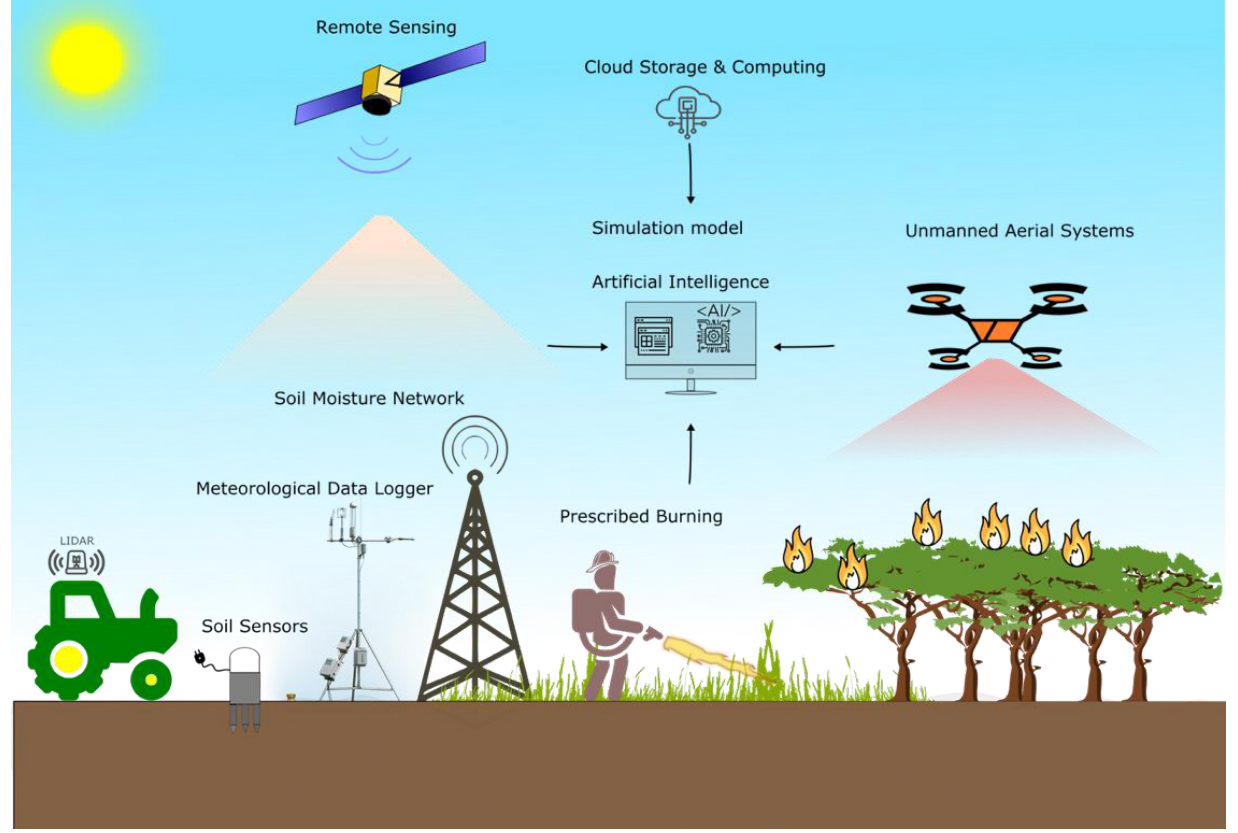
Figure 1. Illustration depicting how current wildfire prediction and analytics are data driven. Data range from soil sensors installed in a plot, information on fire management practices at the field level, uncrewed aerial systems, acquired hyperspectral data, LiDAR data, and remotely sensed satellite information at the landscape level. Quality data obtained at each scale are critical for wildfire prediction analytics and fire simulation studies.